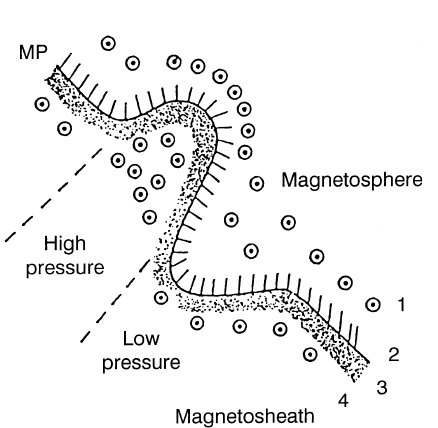
Fig. 1. The wavy downside magnetopause boundary. The magneto- sphere is labelled 1, the low-latitude boundary layer as 2, the plasma depletion layer as 3, and the magnetosheath as 4 (from Sibeck et